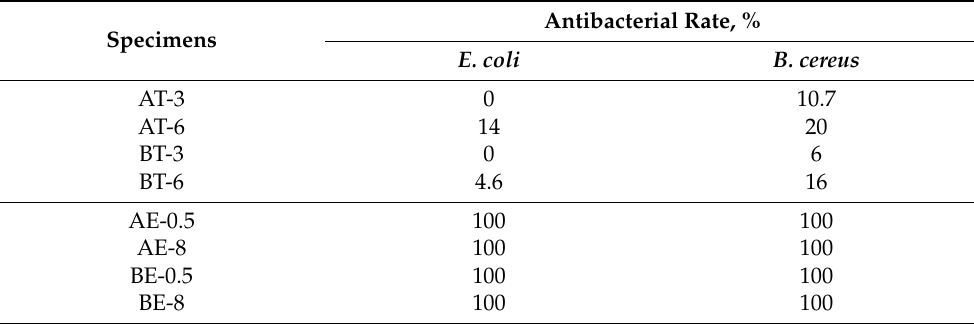
Table 3. Antibacterial activity of silver-doped alumina substrates after contamination with E. coli or B. cereus and subsequent 24 h